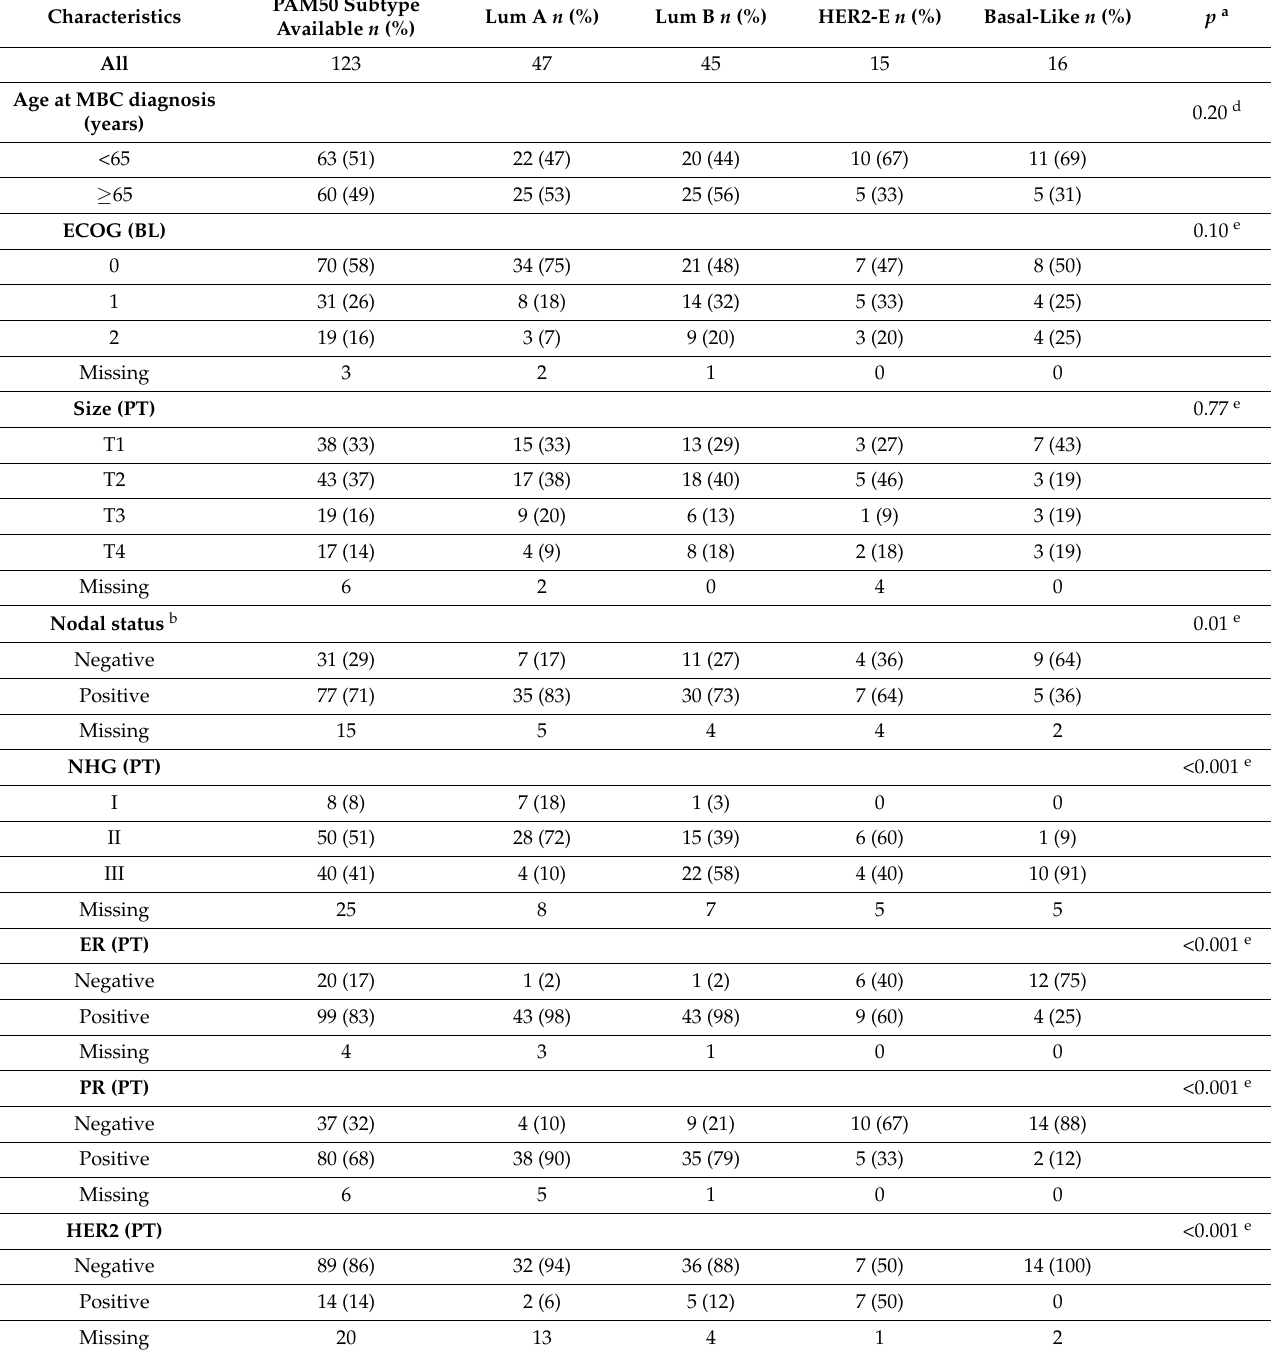
Table 1. Patient and tumor characteristics for primary tumors in the PAM50 cohort and subdivided into patients with subtype available and the different breast cancer intrinsic